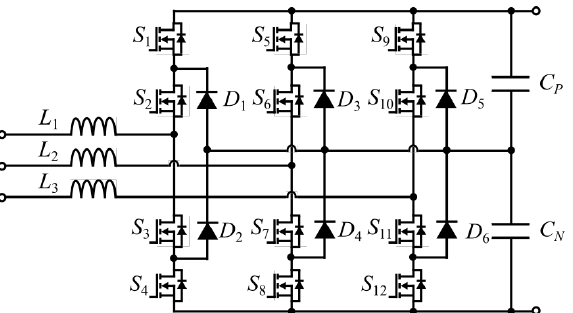
Figure 11. Three-phase three-level neutral point clamped converter.